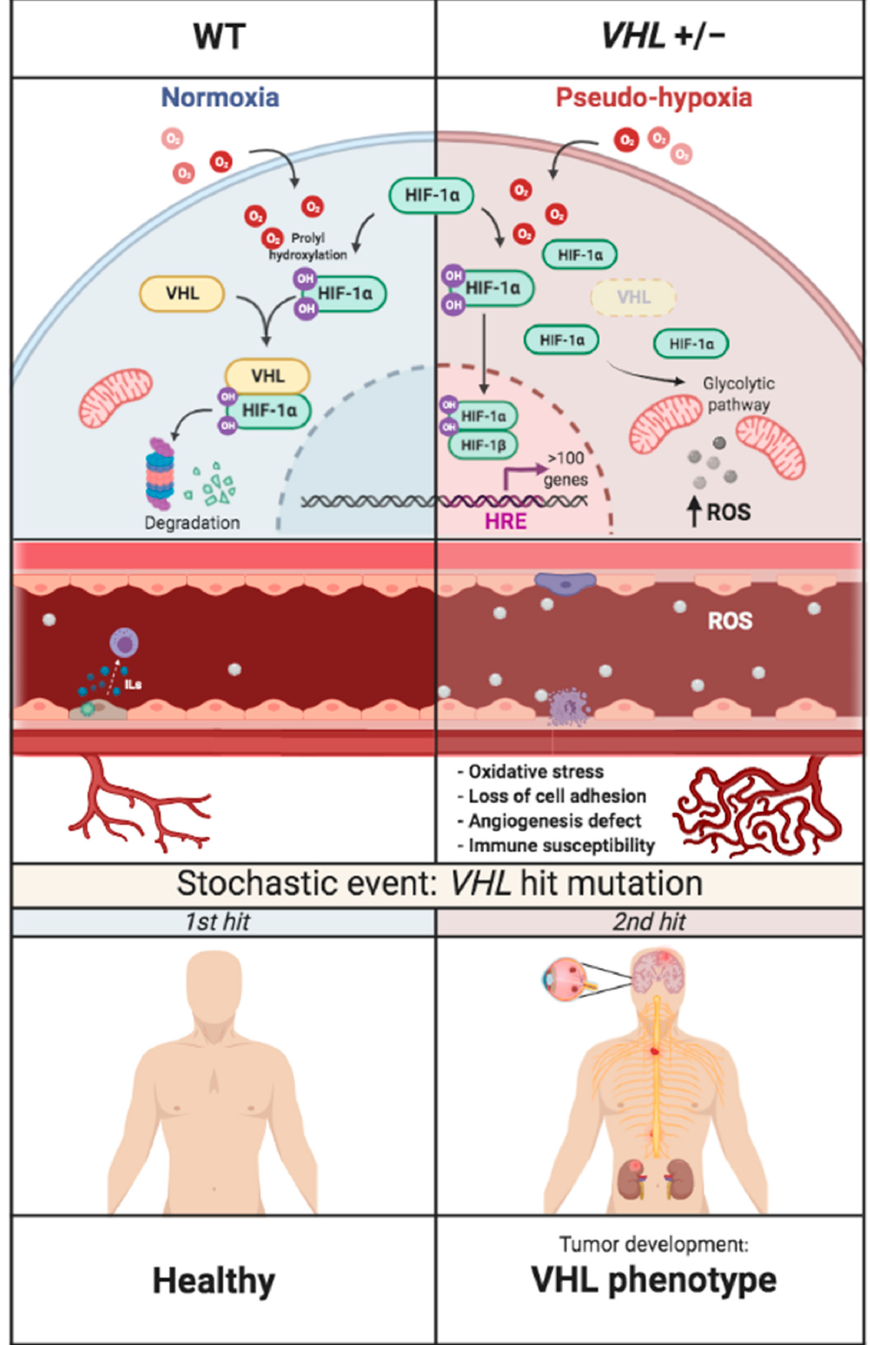
Figure 9. Flow chart of the development of VHL disease. The absence of pVHL promotes the accumulation of HIF-1 in the cell and thus a state of permanent pseudo-hypoxia, manifested by loss of adhesion capacity, defective angiogenesis, immune susceptibility, and altered metabolism, inducing prolonged oxidative stress. The endothelium of these patients is partially dysfunctional and more susceptible to tumor development. All this precedes the second hit mutation in VHL that triggers tumorigenesis.